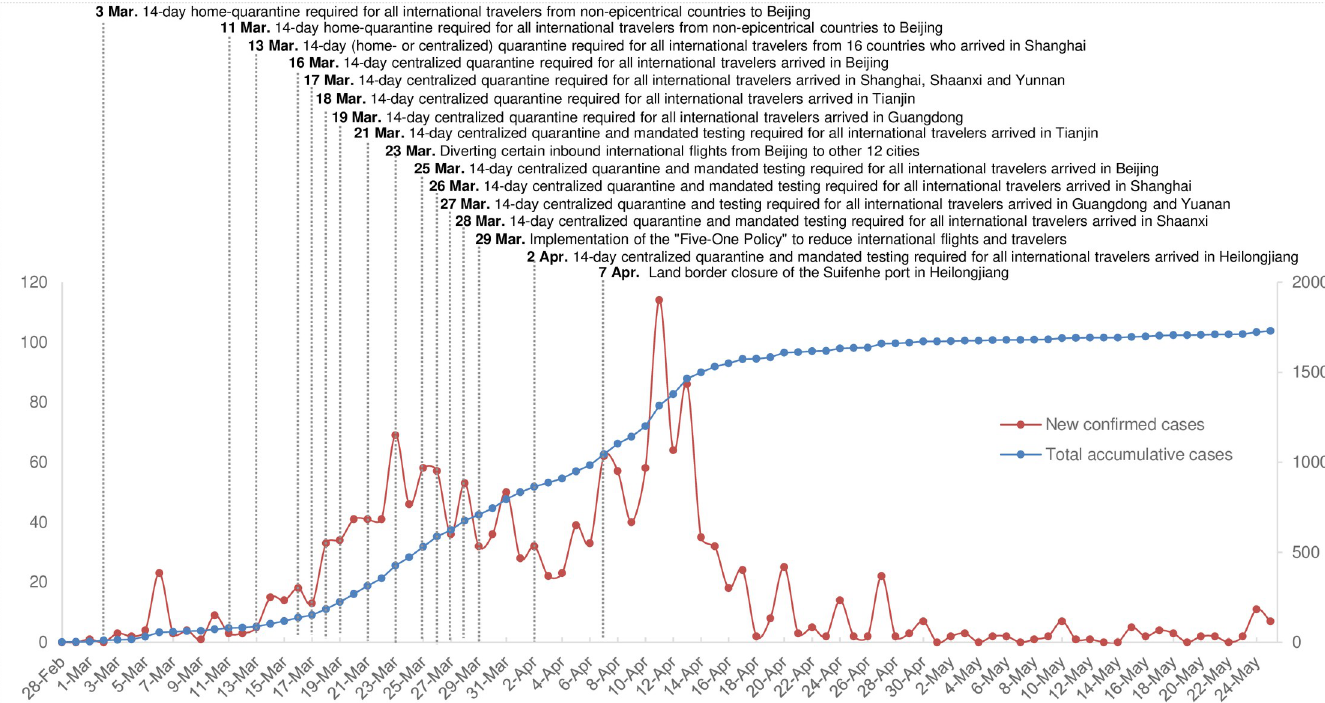
Fig 1. Multi-dimensional interventional policies and the distributions of imported confirmed cases and their diagnosis intervals. The figure illustrates the evolution of abrupt upsurge of COVID-19 imported cases and the progressive multi-dimensional policies implemented in China from February 29 to May 25, 2020 (and no imported case was reported during May 26–31,